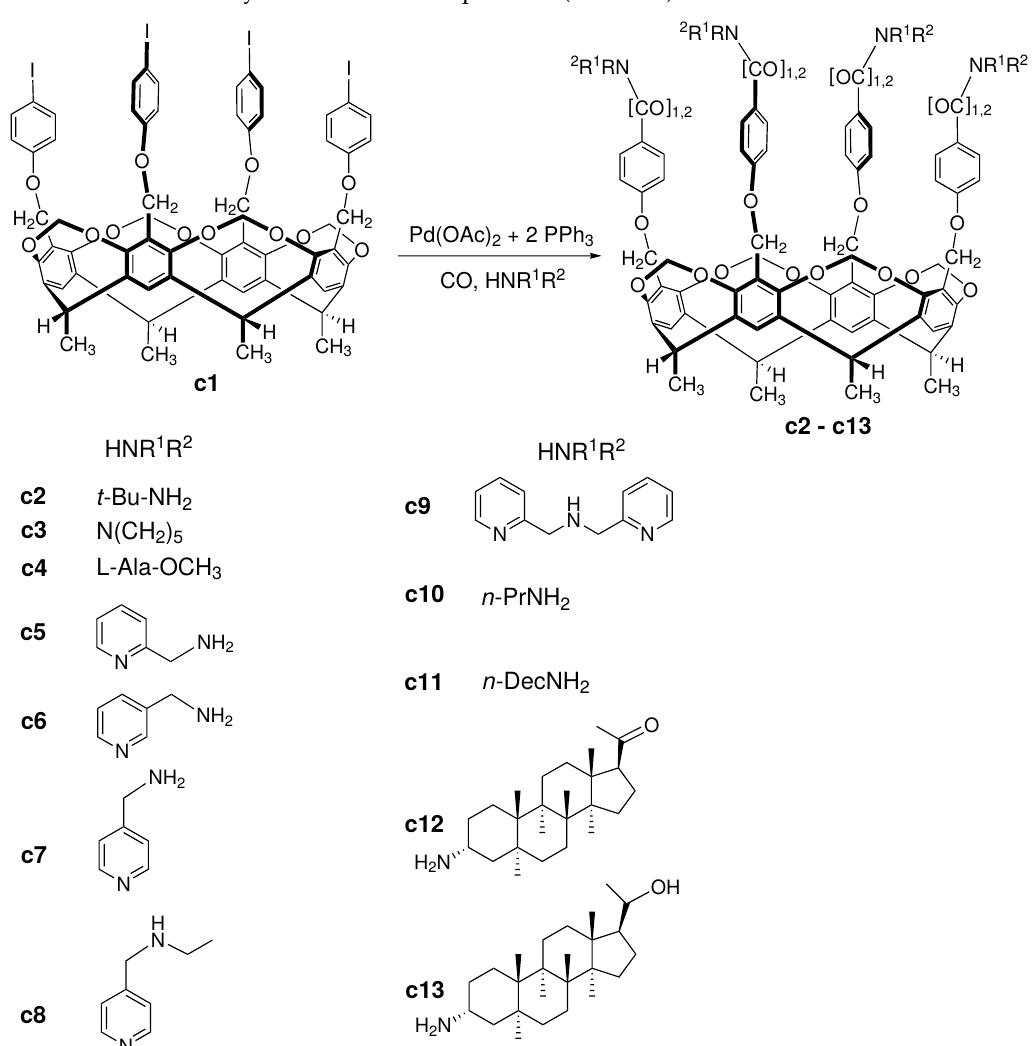
propylamine ( c10 ) [94], n -decylamine ( c11 ) [94]) and secondary amines (piperidine ( c3 ) [90], 4-(ethylaminomethyl)pyridine ( c8 ) [91], di-(2-picolyl)amine ( c9 ) [91]), a chiral amino acid (L-alanine methyl ester hydrochloride ( c4 ) [90]) and aminosteroids (3 α -amino-5 α -pregnan- 20-one ( c12 ), 3 α -amino-5 α -pregnan-20-ol ( c13 ) [92]) were employed as N -nucleophile